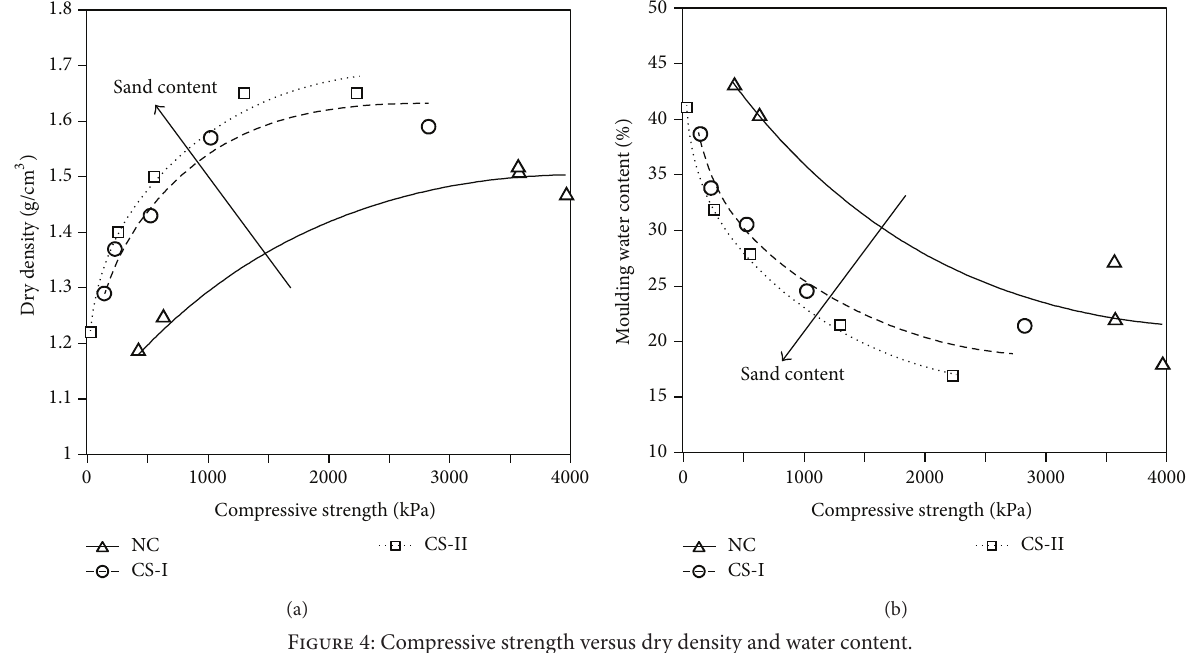
Figure 4: Compressive strength versus dry density and water